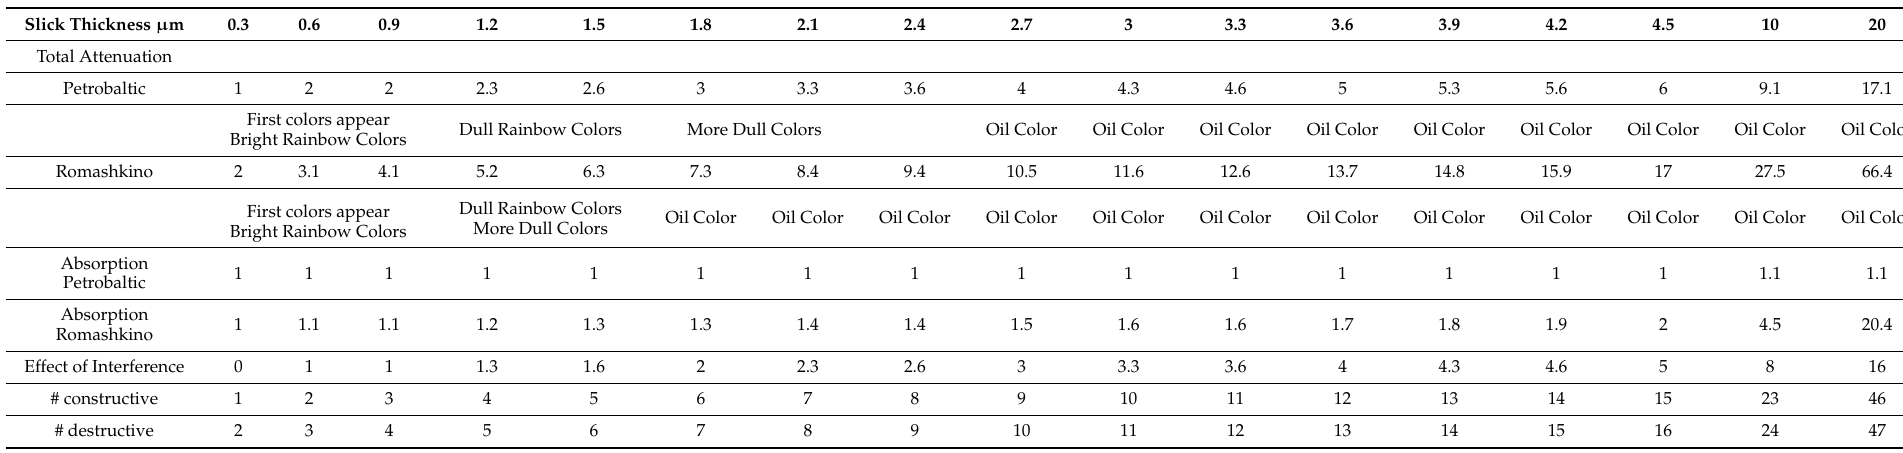
Table 3. Effect of absorption and